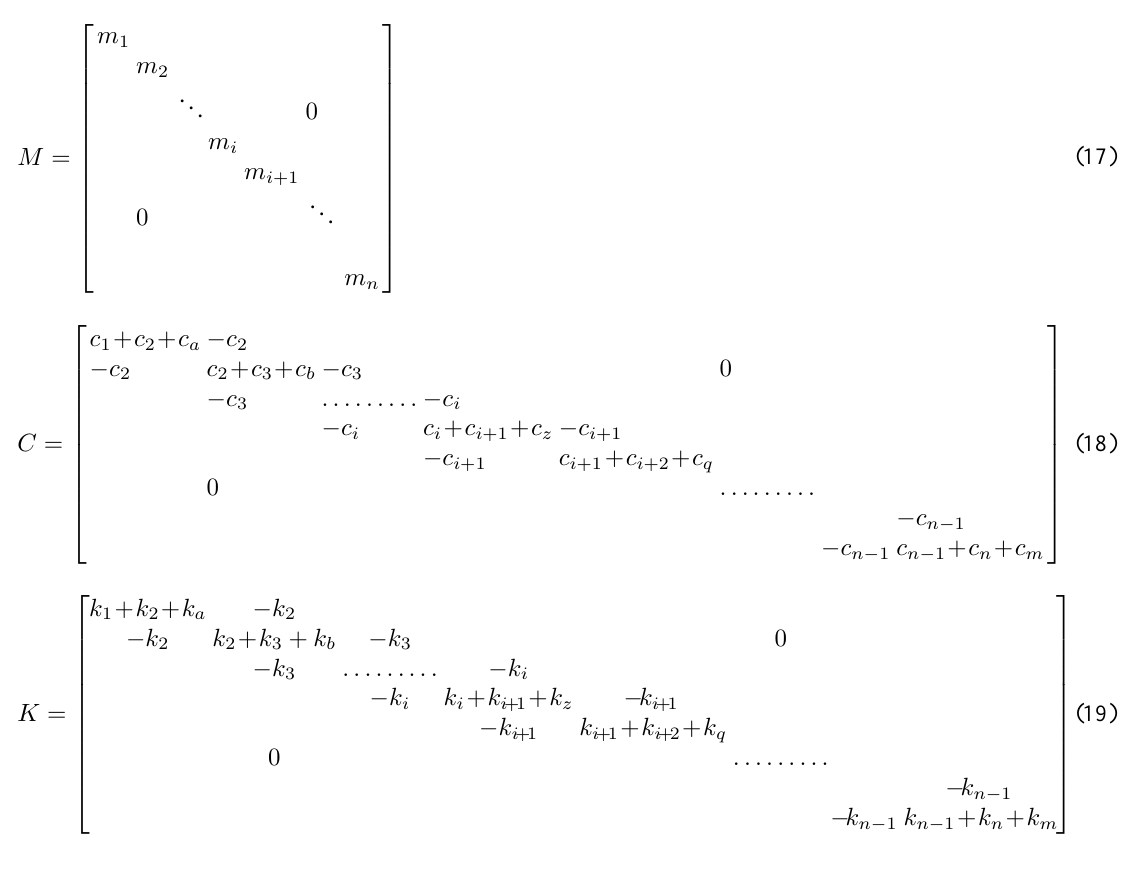
Fig. 8. Displacement of main mass